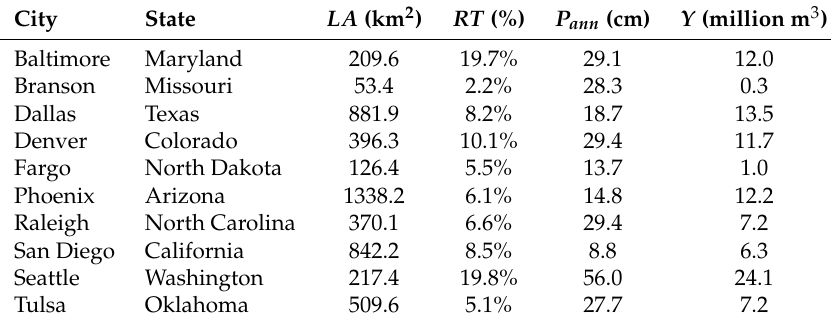
Table A1. Maximum potentialrainwater harvesting yield values for 10 U.S.